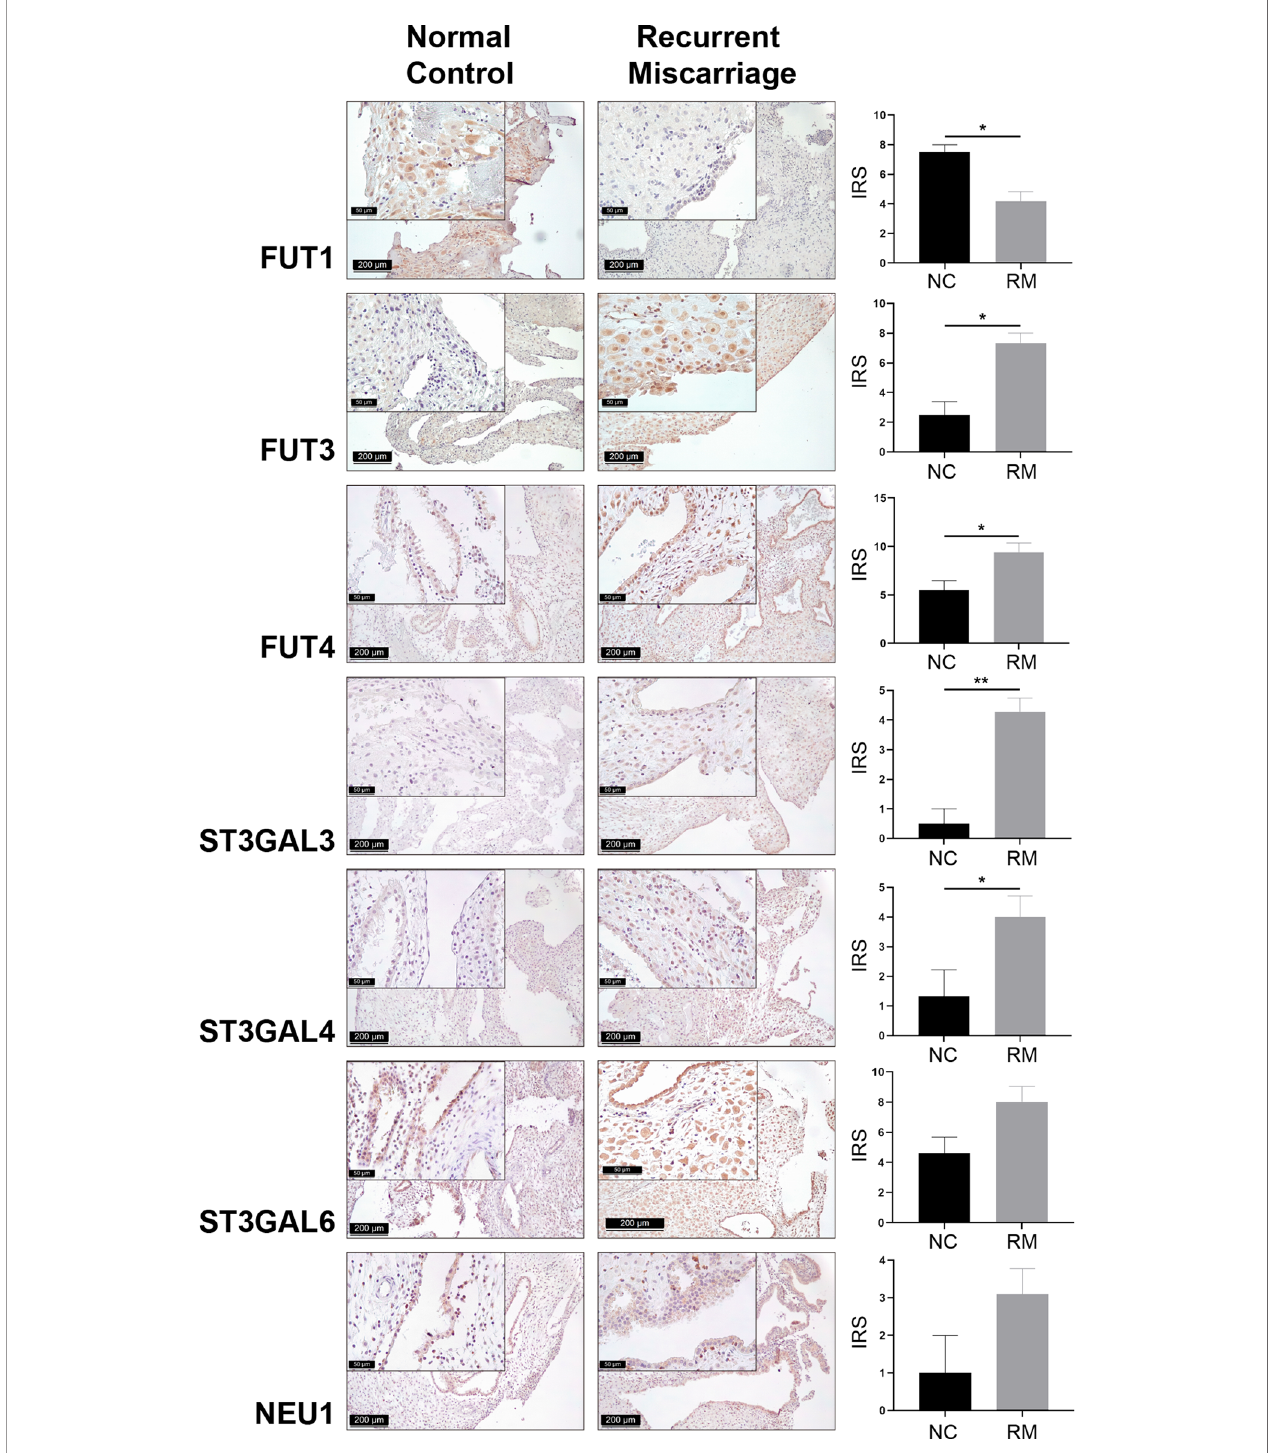
FIGURE 4 | Immunohistochemical staining of seven Lewis antigens associated key modulators in the decidua of Normal Control group (NC = 10) and Recurrent Miscarriage group (RM = 15) of placenta tissues, demonstrating higher expression of FUT3/4 and ST3GAL3/4 and lower expression of FUT1 in RM than NC. IRS, immunoreactive score. Error bars, S.E.M. * P < 0.05, ** P < 0.01.